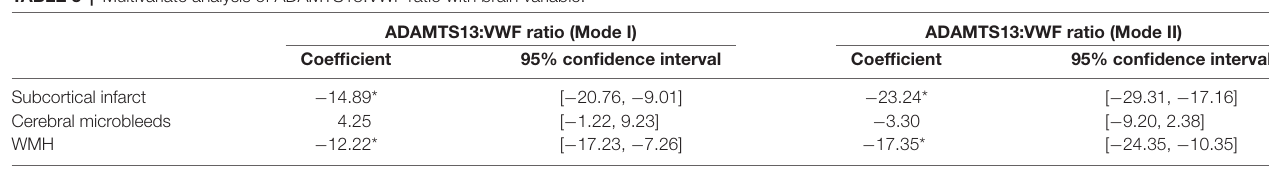
TABLE 3 | Multivariate analysis of ADAMTS13:VWF ratio with brain variable.